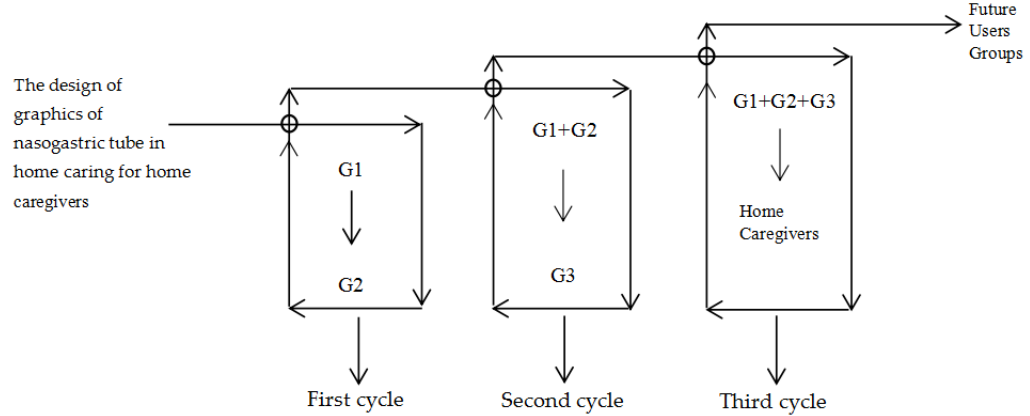
Figure 2. Target participants group structure diagram.